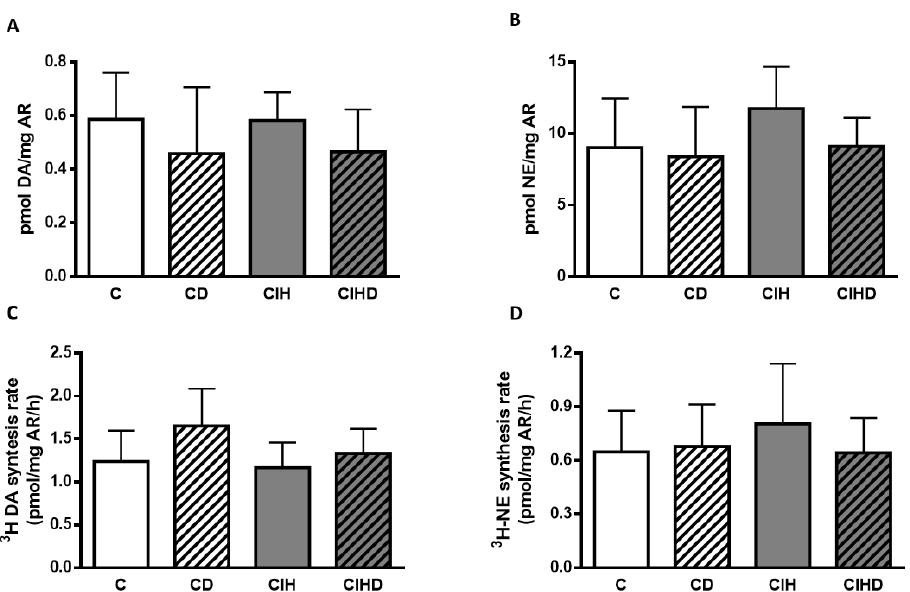
Figure 4. Catecholamine content and rate of synthesis from renal artery. In ( A , B ) content of DA and NE in renal arteries (RA) from the four group of animals. Data are mean and SD of 7–10 individual data from each group; One-way ANOVA. In ( C , D ) rate of 3 H-DA and 3 H-NE synthesis expressed as pmol / mg tissue / h in RA. Data are mean and SD from 6-10 individual values. One-way ANOVA.